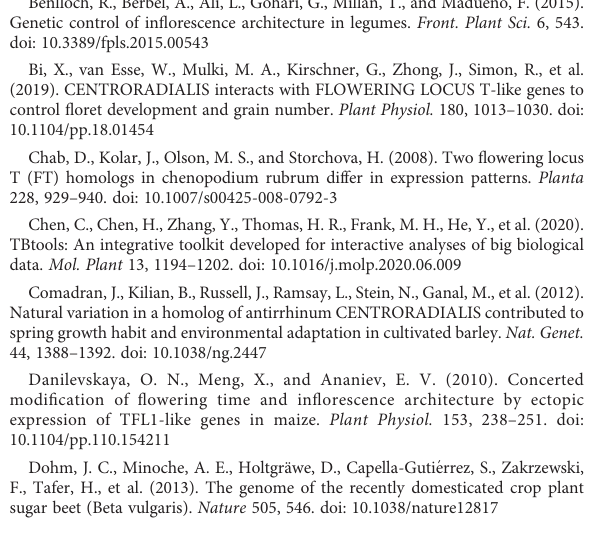
SUPPLEMENTARY FILE 3 Expression pro fi les of the TFs in blue